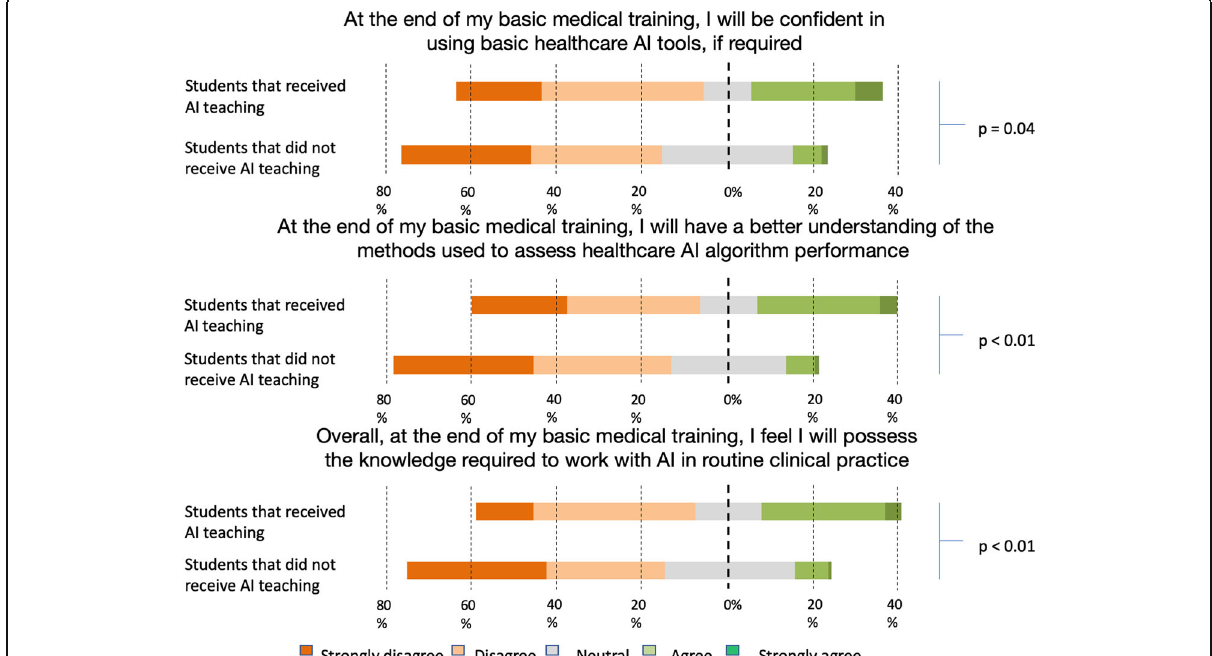
Fig. 5 Comparison of perceived preparedness in the critical use of AI between students who receive AI teaching against those that did